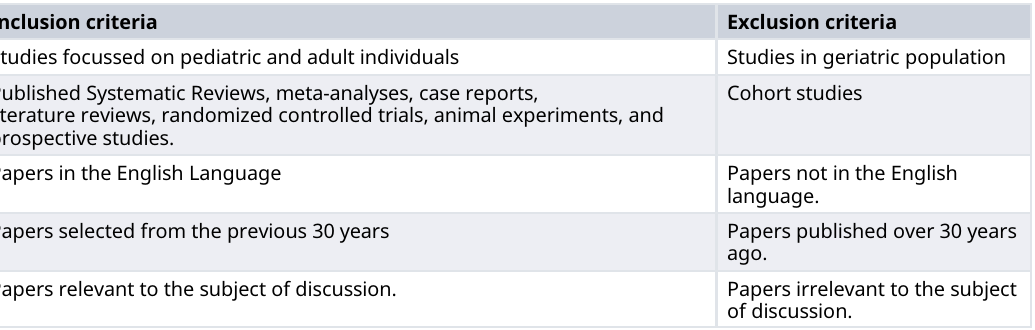
Table 1. Inclusion and exclusion